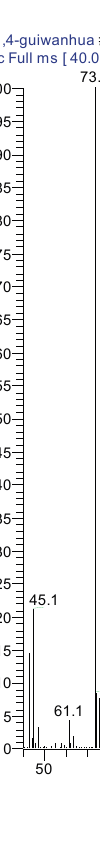
Figure 10. MS spectrum of a silane-derivatized sample at peak 24.41